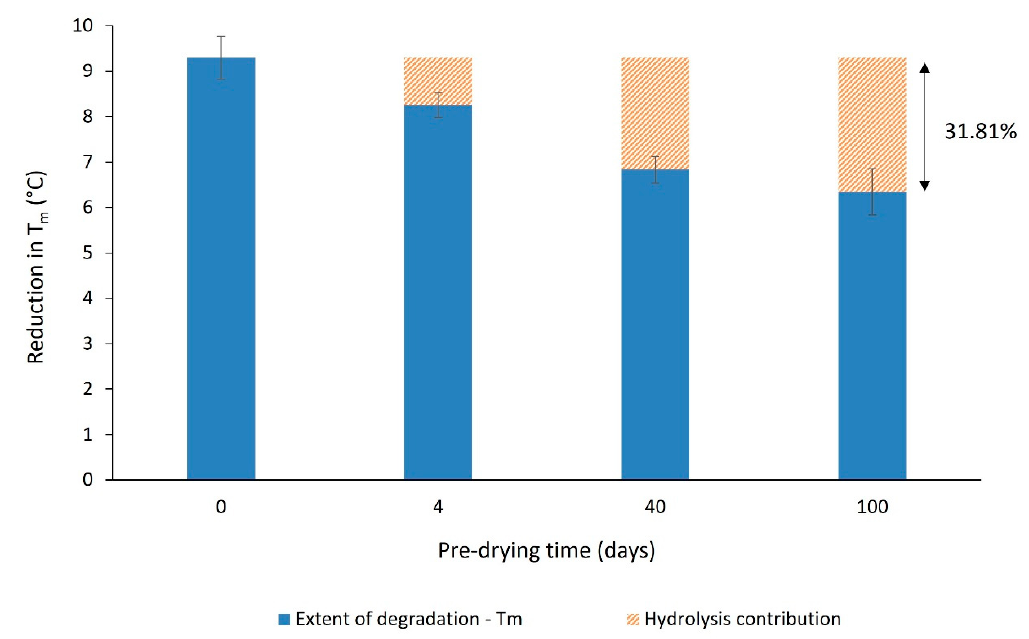
Figure 13. The reduction in melting temperature of PA-12, as a function of pre-drying time. Changes in T m were calculated from the highest value during oven storage to the final value observed after 336 h.